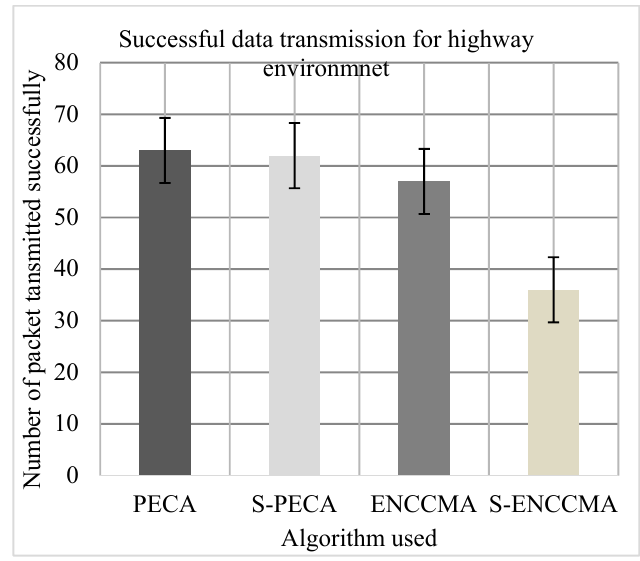
Figure 14. Successful transmission for highway.